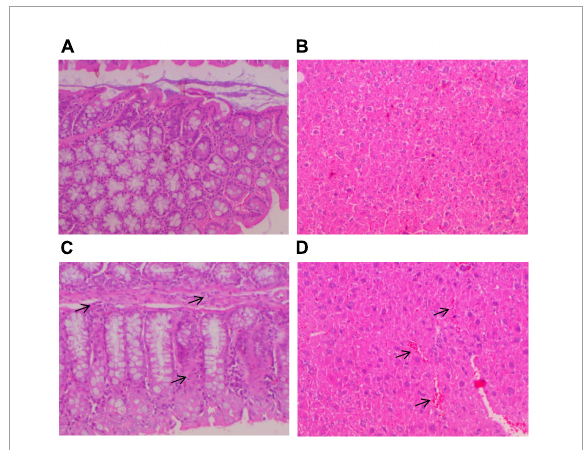
FIGURE2 Histopathological analysis of colon and liver tissues of elderly mice. At the end of the treatment period, the mice were anesthetized and killed by cervical dislocation for tissue removal. Liver and gut tissues were kept in 10% formalin solution before being embedded in paraplast, sectioned using a microtome (4 µ m sections) and stained with Hematoxylin-Eosin (H/E). The tissue sections were examined twice in a Nikon E400 microscope by three pathologists independently at different time points. (A) Colon and (B) liver tissues without any histopathological alterations; (C) colon tissue with small number of eosinophil leucocytes in the mucosal enteric crypts (arrows); (D) liver tissue with mild liver sinusoidal/canalicular dilatation (arrows).